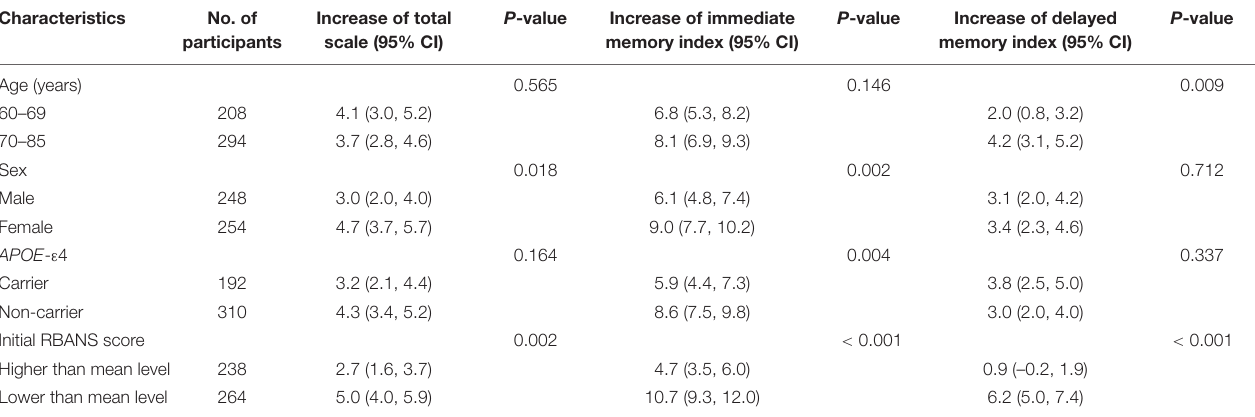
TABLE 3 | Associations between other characteristics and magnitude of repeatable battery for the assessment of neuropsychological status (RBANS) practice effects ( N = 502).